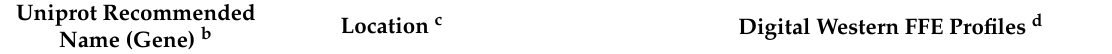
Table 3. Digital western FFE profiles of markers of cargo transport-involved subcellular compartments a .